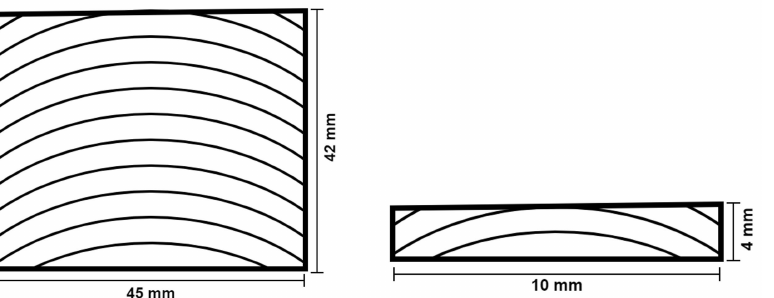
Figure 1. Illustration of the supplied cross-section dimensions of pine, highlighting the preferable ring orientation.